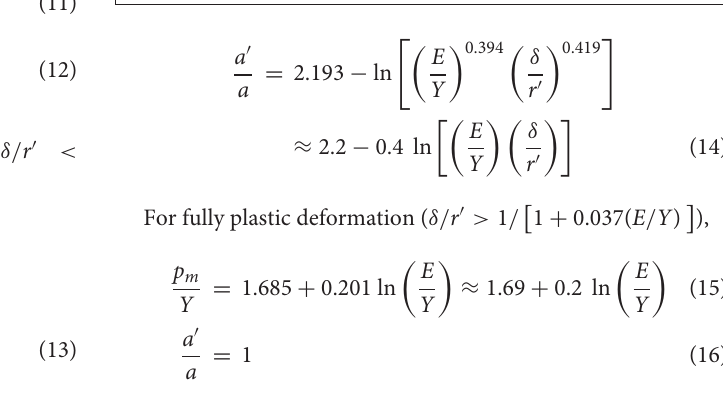
FIGURE 5 | Dimensionless mean contact pressure p m / Y vs. dimensionless local surface interference δ/ r ′ and effective elastic modulus-to-yield strength ratio E / Y (Kogut and Komvopoulos,